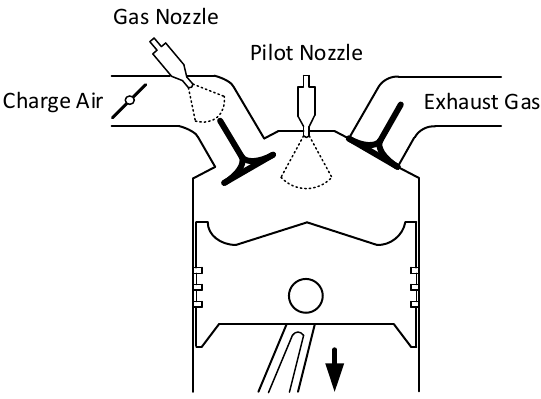
Figure 1. Schematic of the simulated engine